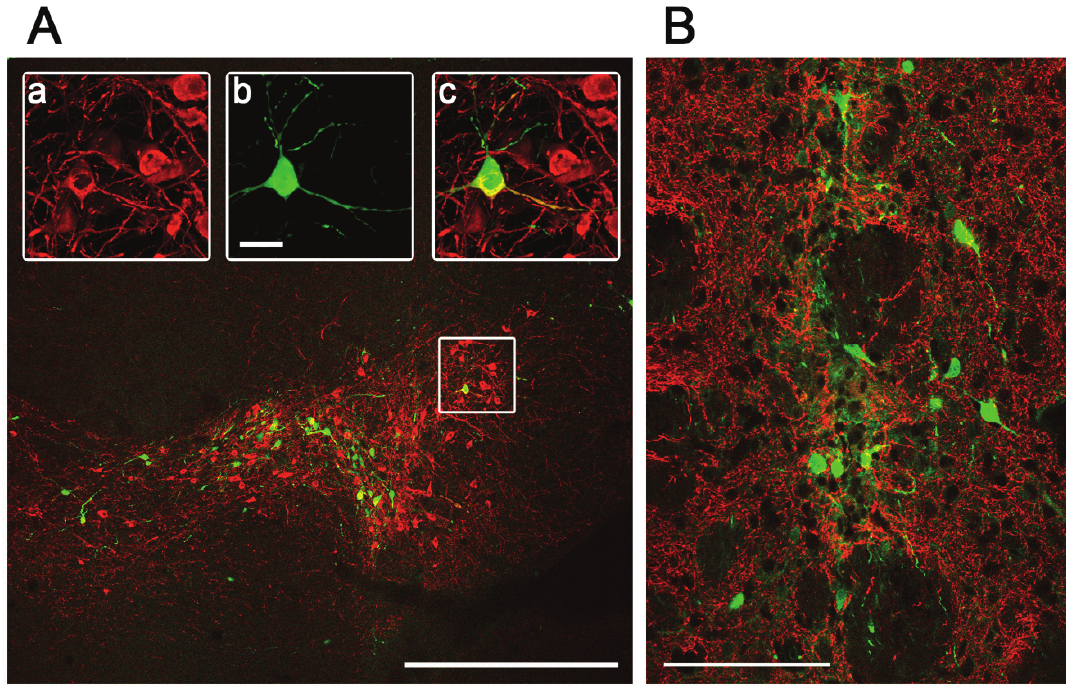
Figure 5. Pattern of Ad5-CGW-CK2-mediated GFP expression at the site of stereotactic delivery. Confocal immunohistochemical analysis of GFP expression by Ad5-CGW-CK2 stereotactically delivered to mouse SN ( A ) and STR ( B ) results in striking neuronal tropism. ( A ) Low-power image of the injected SN. Only neurons are positive for GFP expression. ( a , b , c ) Magnification of the region outlined in ( A ). A TH (red, a)/GFP (green, b) double-positive neuron is clearly visible surrounded by uninfected dopaminergic (DA) neurons (merge, c). ( B ) When Ad5-CGW-CK2 is delivered to the STR, GFP-expressing cells with neuronal morphology are observed. Despite thick (40 µm) sections and assessment of numerous slices around the injection site, no non-neuronal GFP expressing cells could be appreciated in the brains of animals receiving Ad5-CGW-CK2. Red = TH. Green = GFP. Bar in A = 500 μ m. Bar in b (for a, b, c)